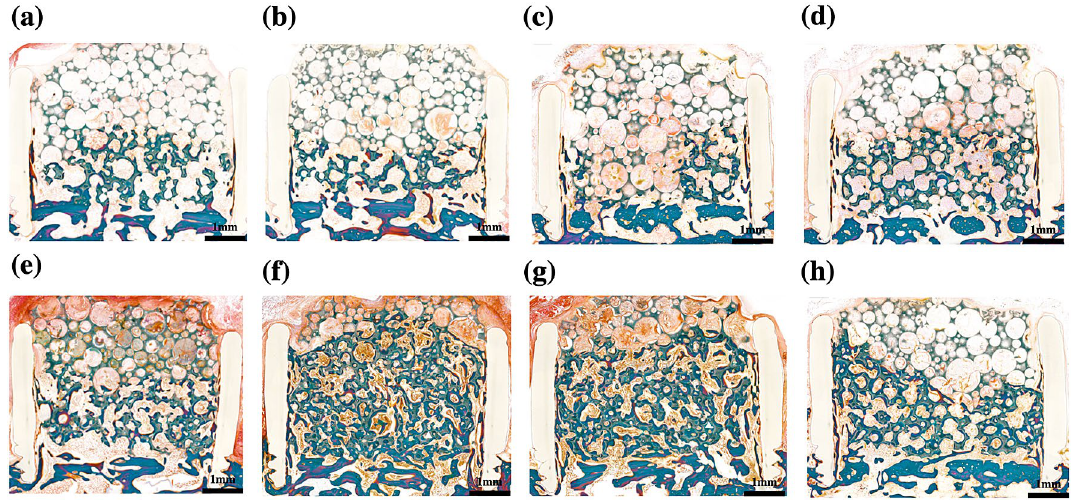
Figure 3. Histomorphometric analysis of new bone formation in response to HA/TCP scaffolds in New Zealand white rabbits 8 weeks post-operation. ( a ) 0.1 mg/mL PDRN; ( b ) 1.0 mg/mL PDRN; ( c ) 5 mg/mL PDRN; ( d ) 10 mg/mL PDRN; ( e ) 0.01 mg/mL rhBMP-2; ( f ) 0.05 mg/mL rhBMP-2; ( g ) 0.1 mg/mL rhBMP-2; ( h ) Control group; (white triangle) new bone. PDRN polydeoxyribonucleotide; rhBMP-2 recombinant human bone morphogenic protein; HA hydroxyapatite; TCP tricalcium